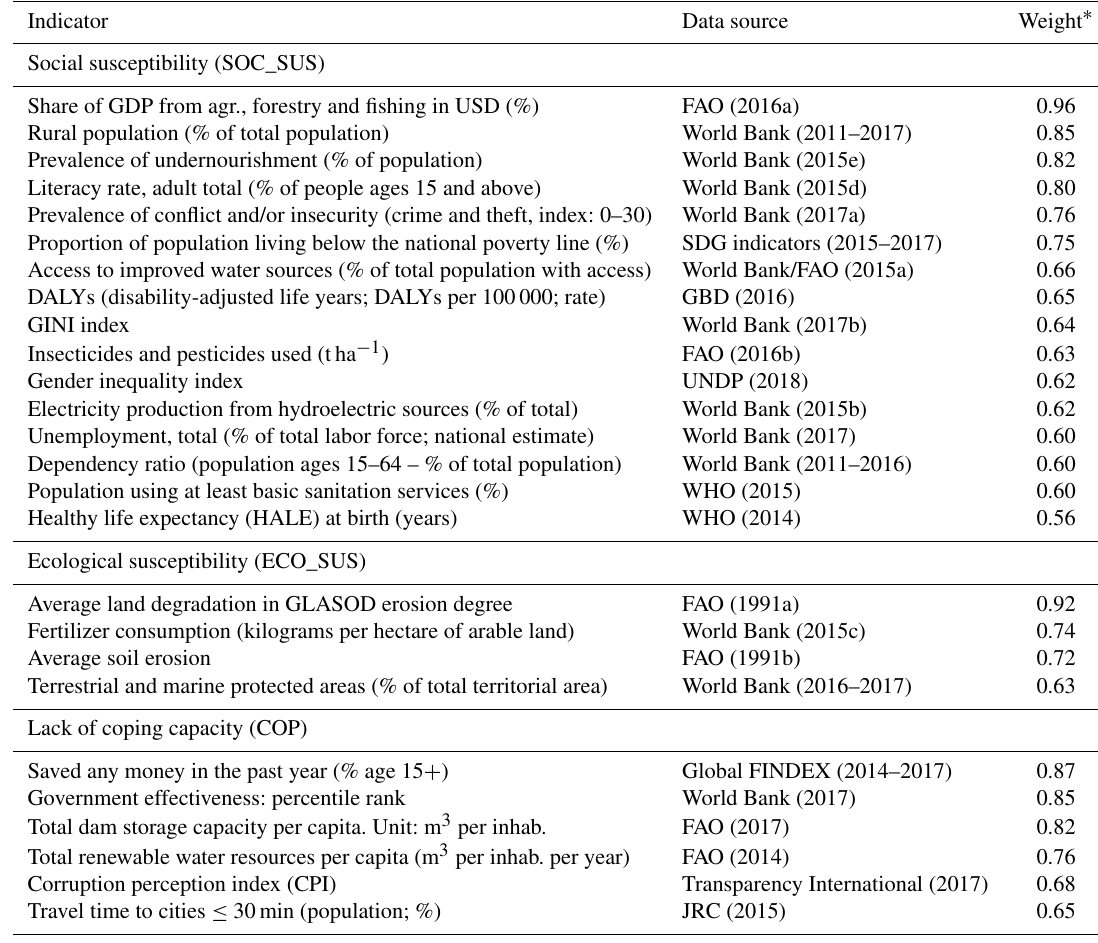
Table 2. Vulnerability indicators used in the analysis and their related expert weights. Indicator Data